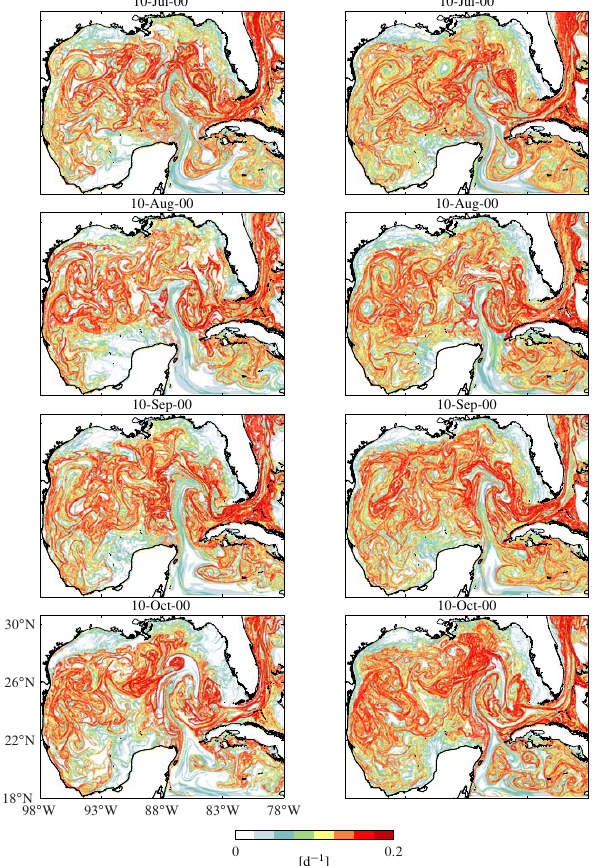
Fig. 3. Sequence of snapshots of Finite-Time Lyapunov Exponent (FTLE) field computed in backward time using simulated surface (left panels) and subsurface (right panels) velocities in the Gulf of Mexico. The subsurface velocities correspond to velocities defined on (isopycnic) subsurface layer k = 6 (cf. Fig. 2). The convoluted bands of most intense red tones indicate attracting Lagrangian Coherent Structures (LCSs).